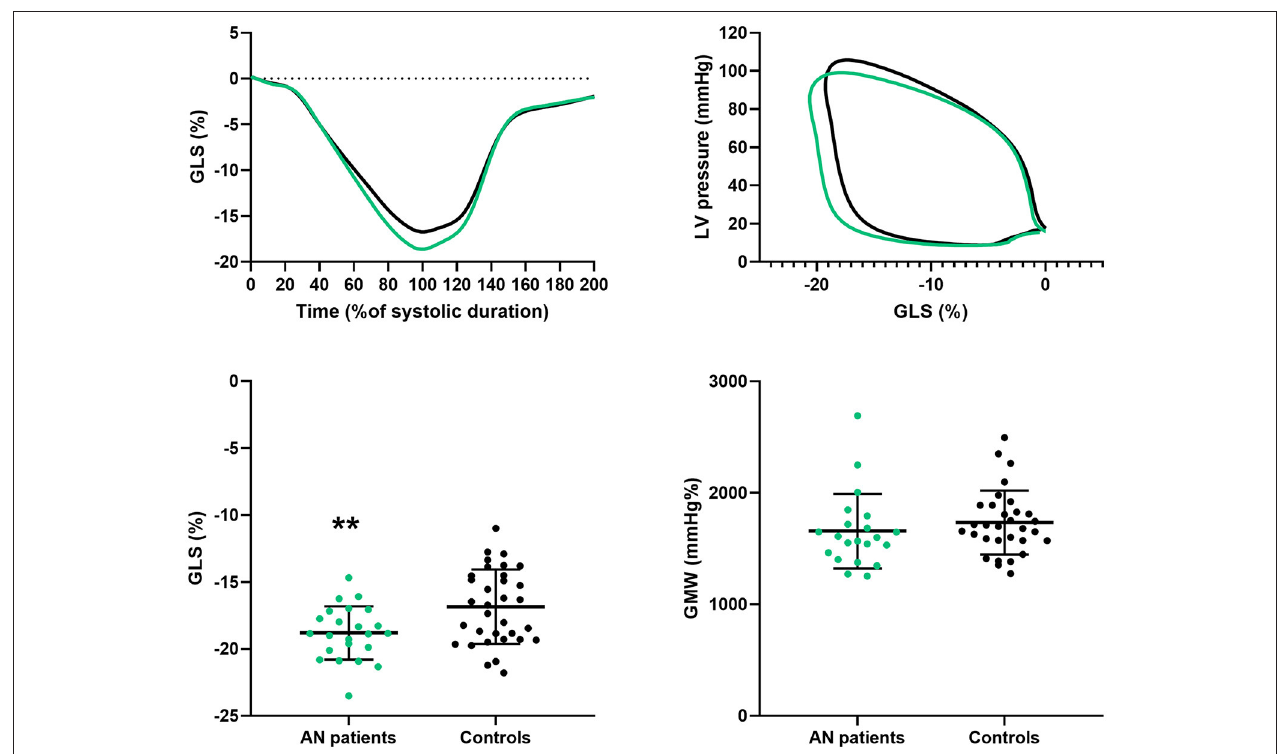
FIGURE 2 | Longitudinal strain and global myocardial work in AN patients and controls. GLS, global longitudinal strain; LV, left ventricular; GMW, global myocardial work. Difference between groups: ** P < 0.01.